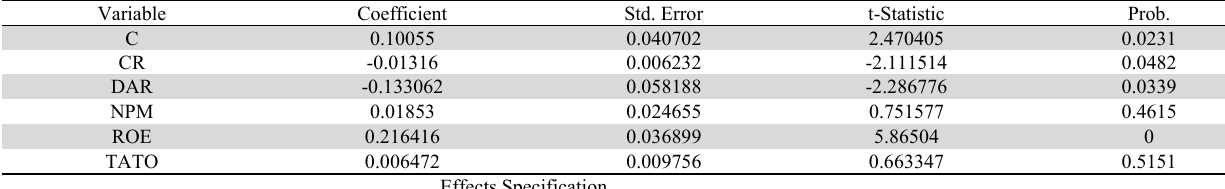
Results of the Fixed Effect Model Data Panel